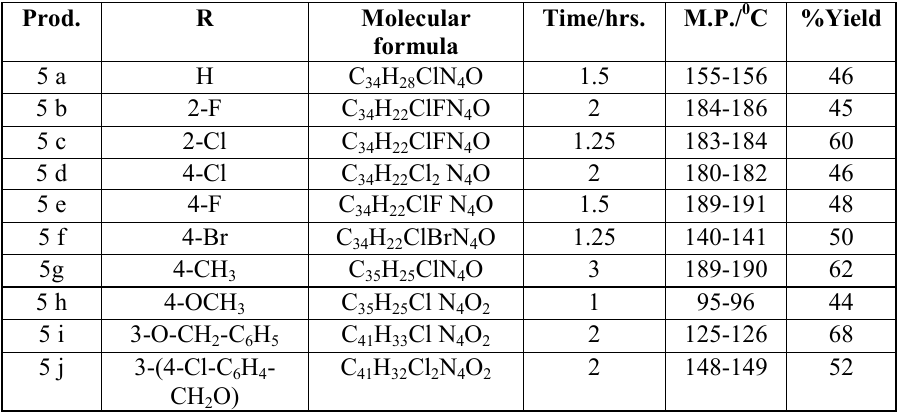
Table 3. Reaction times, melting points and yields for the prepared pyrazolines (5a-j). Prod. R Molecular formula